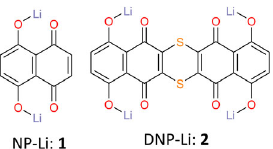
Fig. 1 Chemical structures of the naphthazarin-based organic electrode compounds. Naphthazarin dilithium salt (NP-Li): 1 and tetra lithium salt of